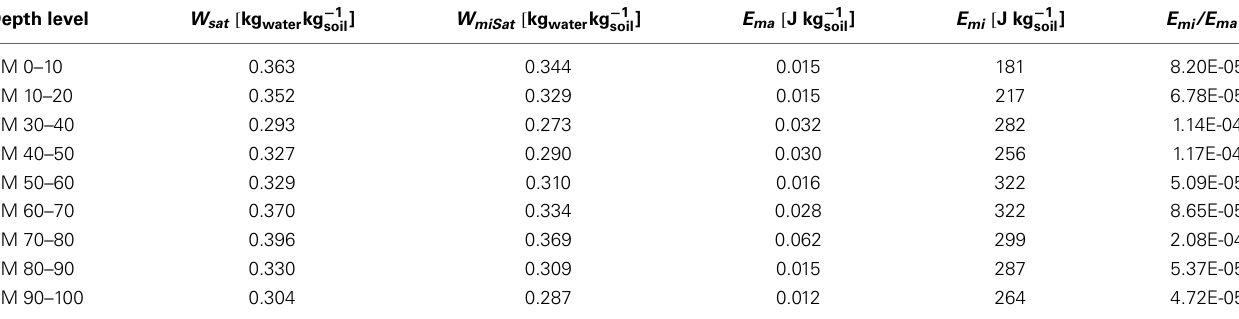
Table 6 | Pedostructural water retention curve parameters obtained by fitting the corrected Chimney Meadow soil water retention curves with the theoretical